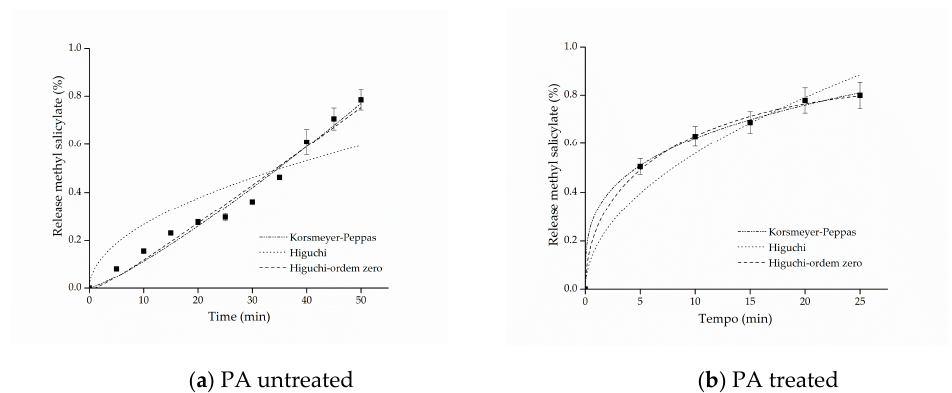
Figure 7. Kinetic adjustments of the profiles of controlled release from ( a ) polyamide (PA) untreated and ( b ) PA treated.